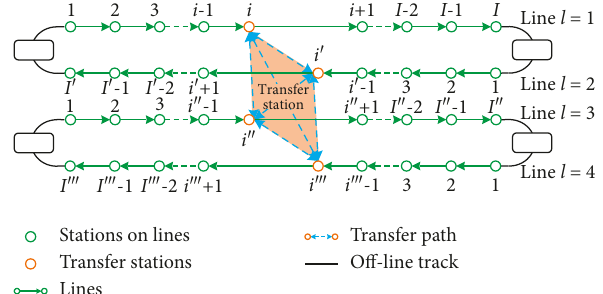
Figure 1: Illustration of a rail transit